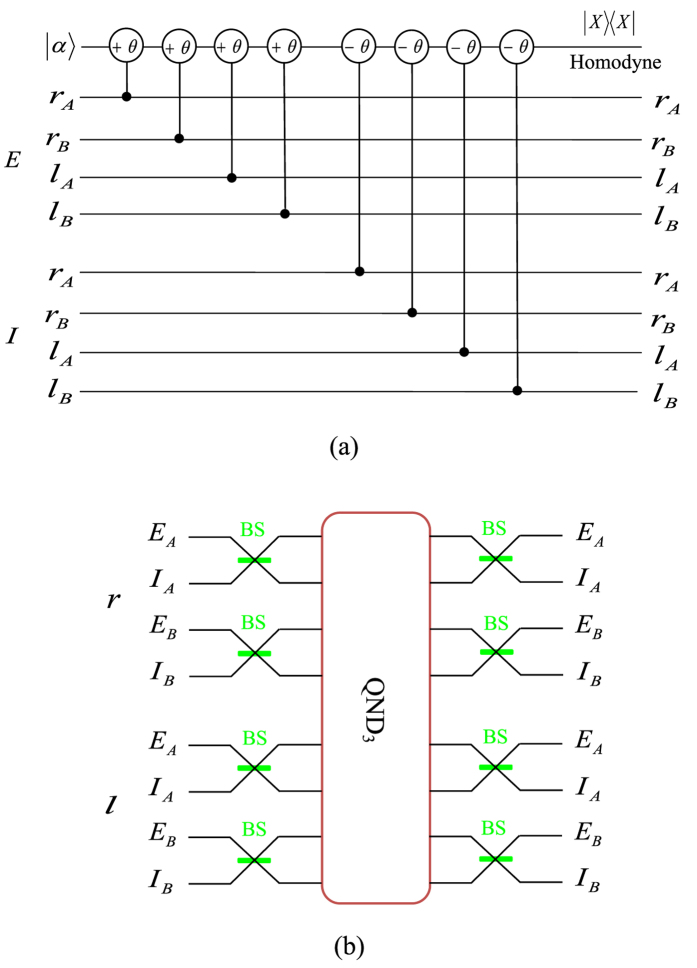
Schematic diagram for distinguishing the four Bell states of the two-photon six-qubit system in the second longitudinal momentum DOF.(a) QND3. (b) QND4, the 50:50 BS is used to perform the Hadamard operation  on the second longitudinal momentum DOF of photons.